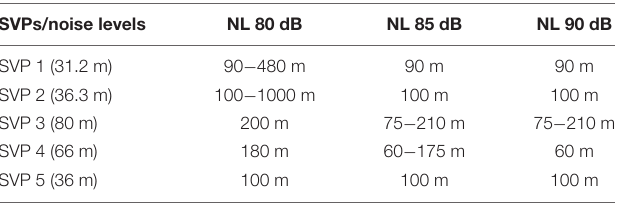
TABLE 2 | Maximum detection ranges in meters of grouper calls simulated by the Personal Computer Shallow Water Acoustic Tool-set for a source level of 140 dB for five sound velocity profiles (SVP) measured on the southern shelf of St. Thomas, US Virgin Islands.